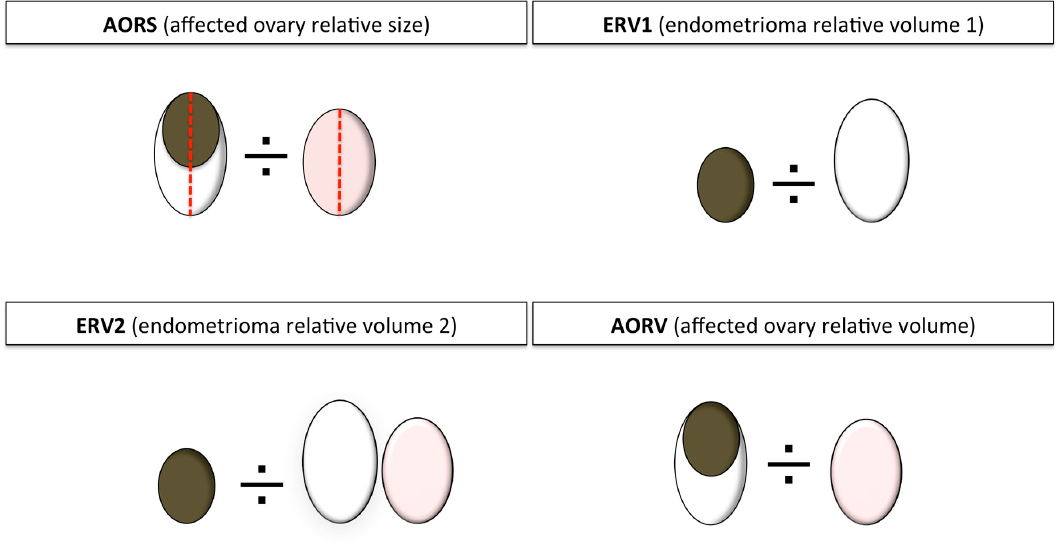
Figure 2. Schematic diagram of the four relative sonographic indicators. Brown circle: Endometrioma; dotted red line: Measure line; pink oval: Contralateral healthy ovary; white oval: Affected ovary.